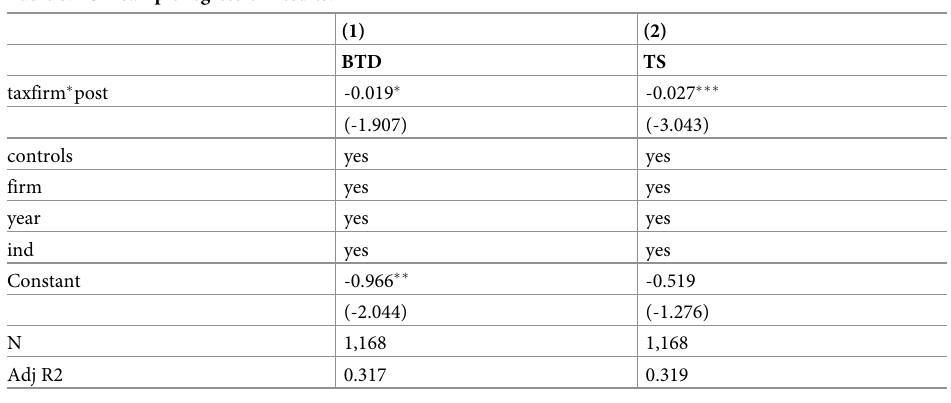
Table 8. PSM sample regression results.